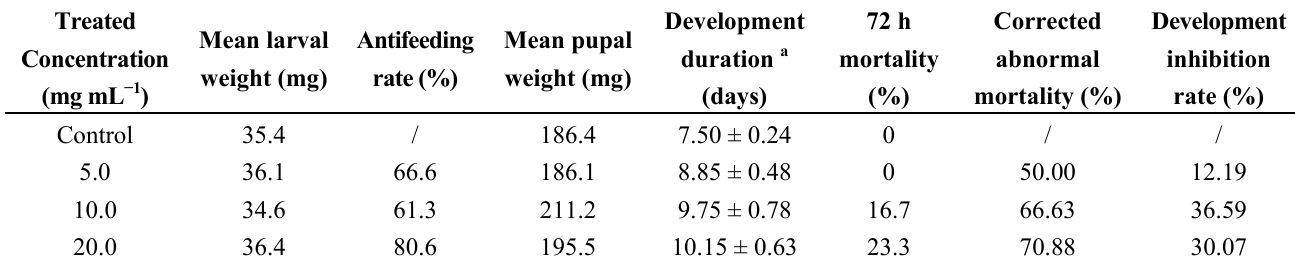
Table 3. Effect of fraxinellone on M. separata feeding and larval development.